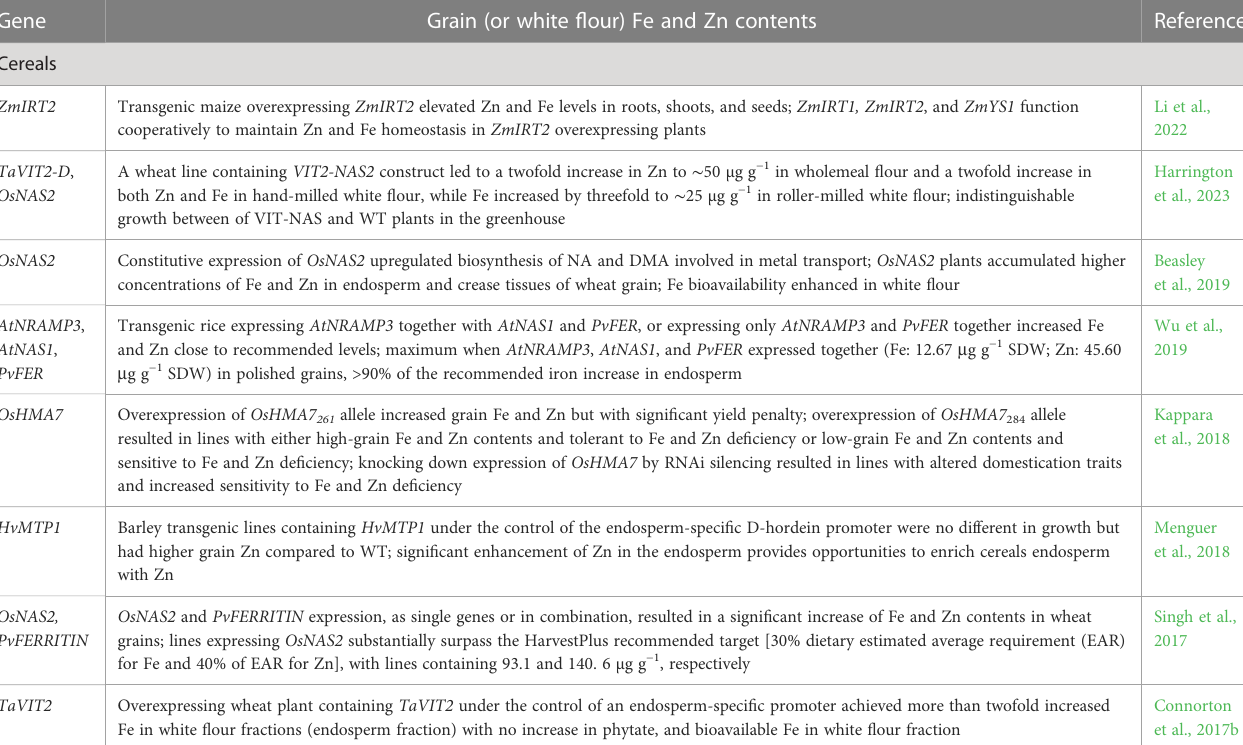
TABLE 4 Functionally characterized genes associated with increased seed Fe and Zn contents in cereal and food legume crops. Gene Grain (or white fl our) Fe and Zn